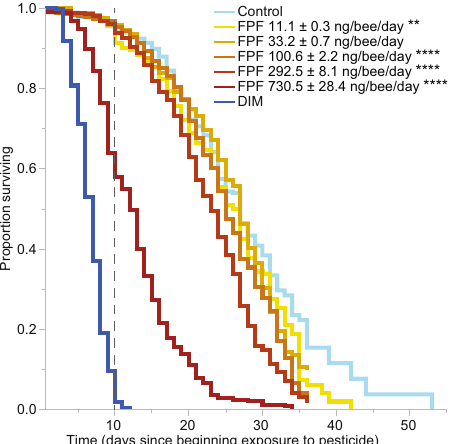
Fig. 1 Effects of fl upyradifurone (FPF) and dimethoate (DIM) on bee survival. We have indicated the end of the 10-day standard test period 36 with a dashed line to facilitate comparison between the standard chronic risk assessment trial (10-day) and our longer term experiment. Only the highest FPF treatment (730.5 ± 28.4 ng/bee/day, mean ± Standard Error of the Mean, SEM) caused a signi fi cant effect before 10 days ( p < 0.0001), while the longer exposure allowed us to determine the signi fi cant effects of lower doses (11.1 ± 0.3 ng FPF/bee/day (mean ± SEM): p < 0.01; 100.6 ± 2.2: p < 0.001; 292.5± 8.1; p < 0.0001; 730.5 ± 28.4: p <